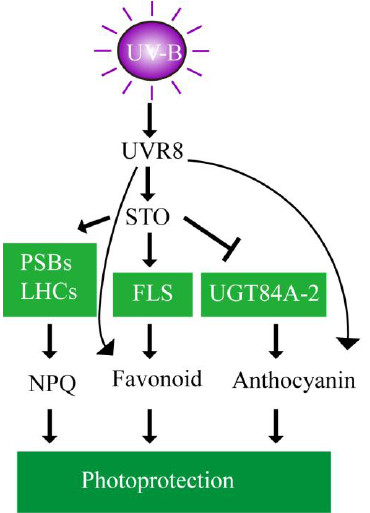
Figure 12. Schematic model of photoprotection mediated by STO in the presence of UV-B radiation. The putative mechanisms are schemed to depict the involvement of STO in UV-B